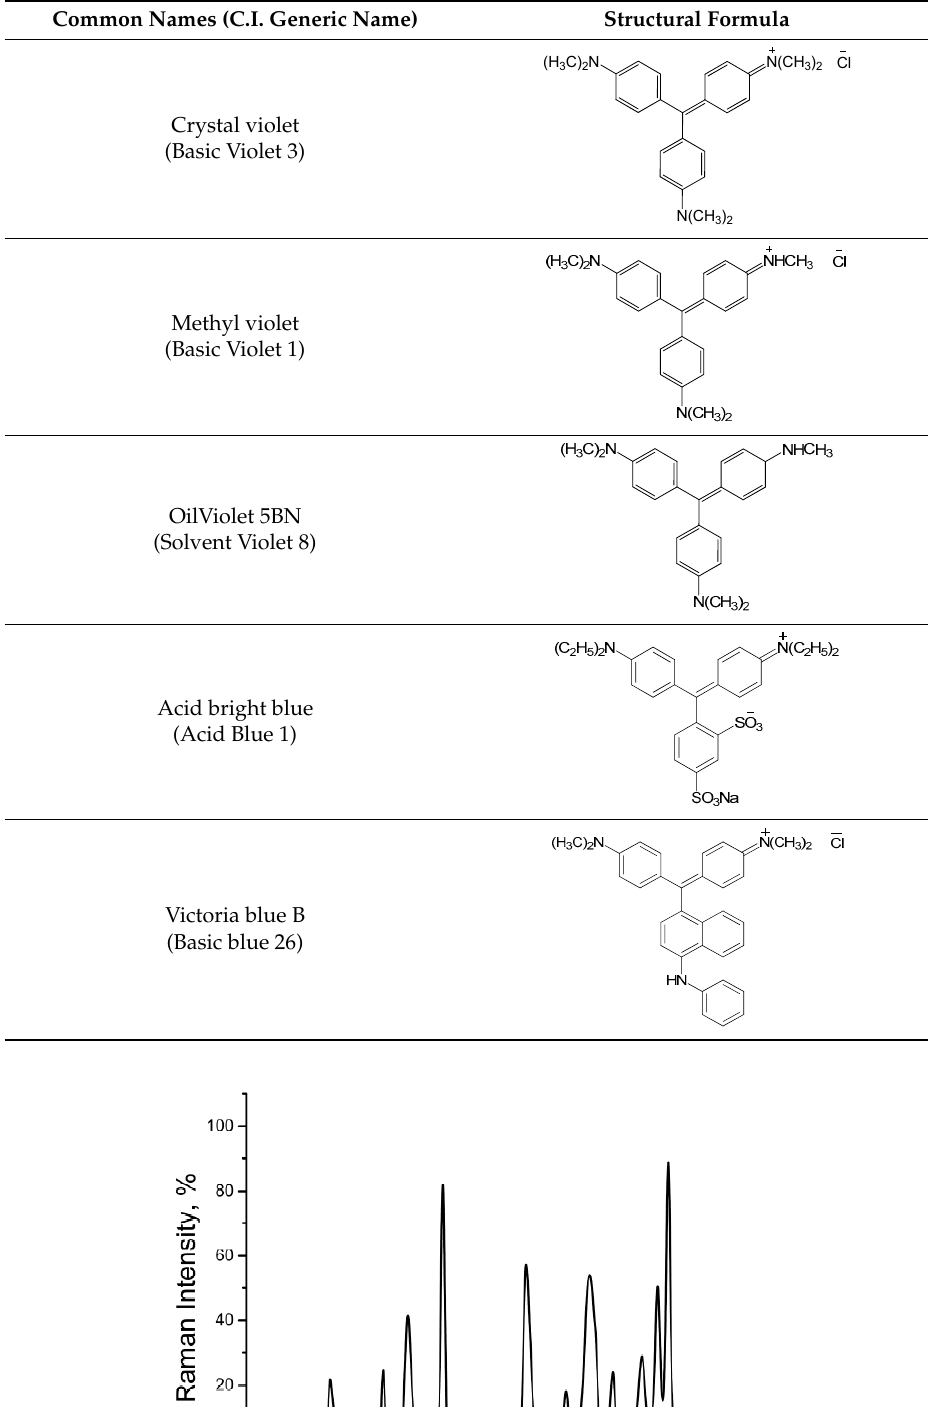
Figure 3. The structure of a copper phthalocyanine molecule. Table 3. The structures of some dyes corresponding to B-type writing inks. Table 3. The structures of some dyes corresponding to B-type writing inks.